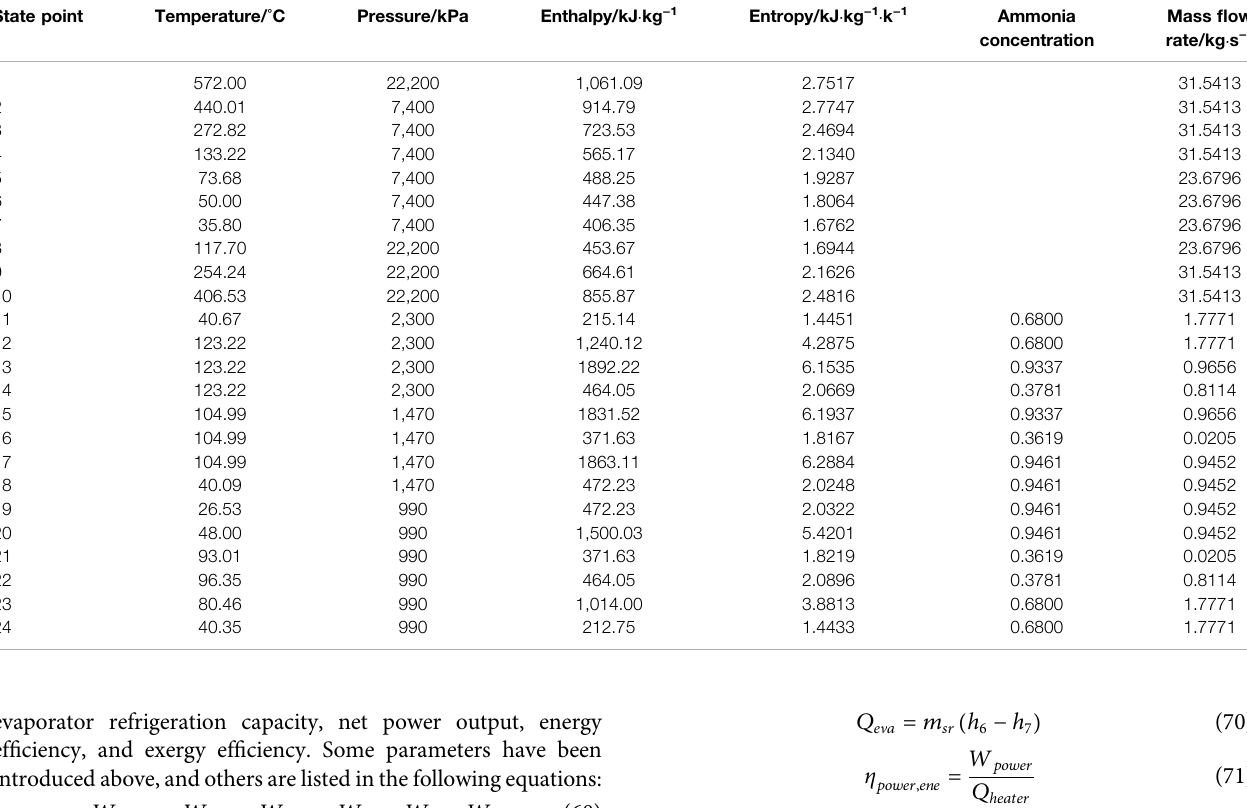
TABLE 4 | System baseline simulation result of state